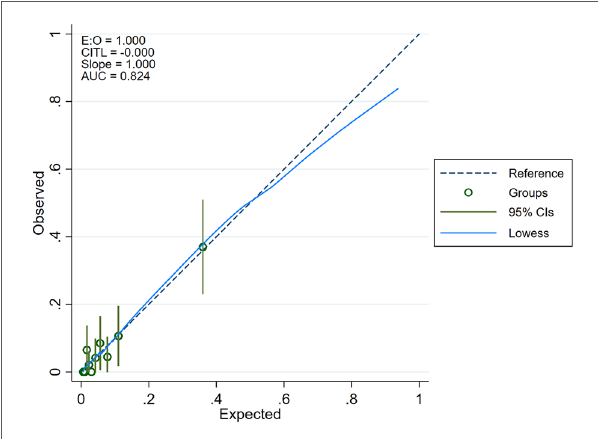
FIGURE 5 Calibration plot of the model that represents perfect prediction that model-predicted probability matches actually observed probability.